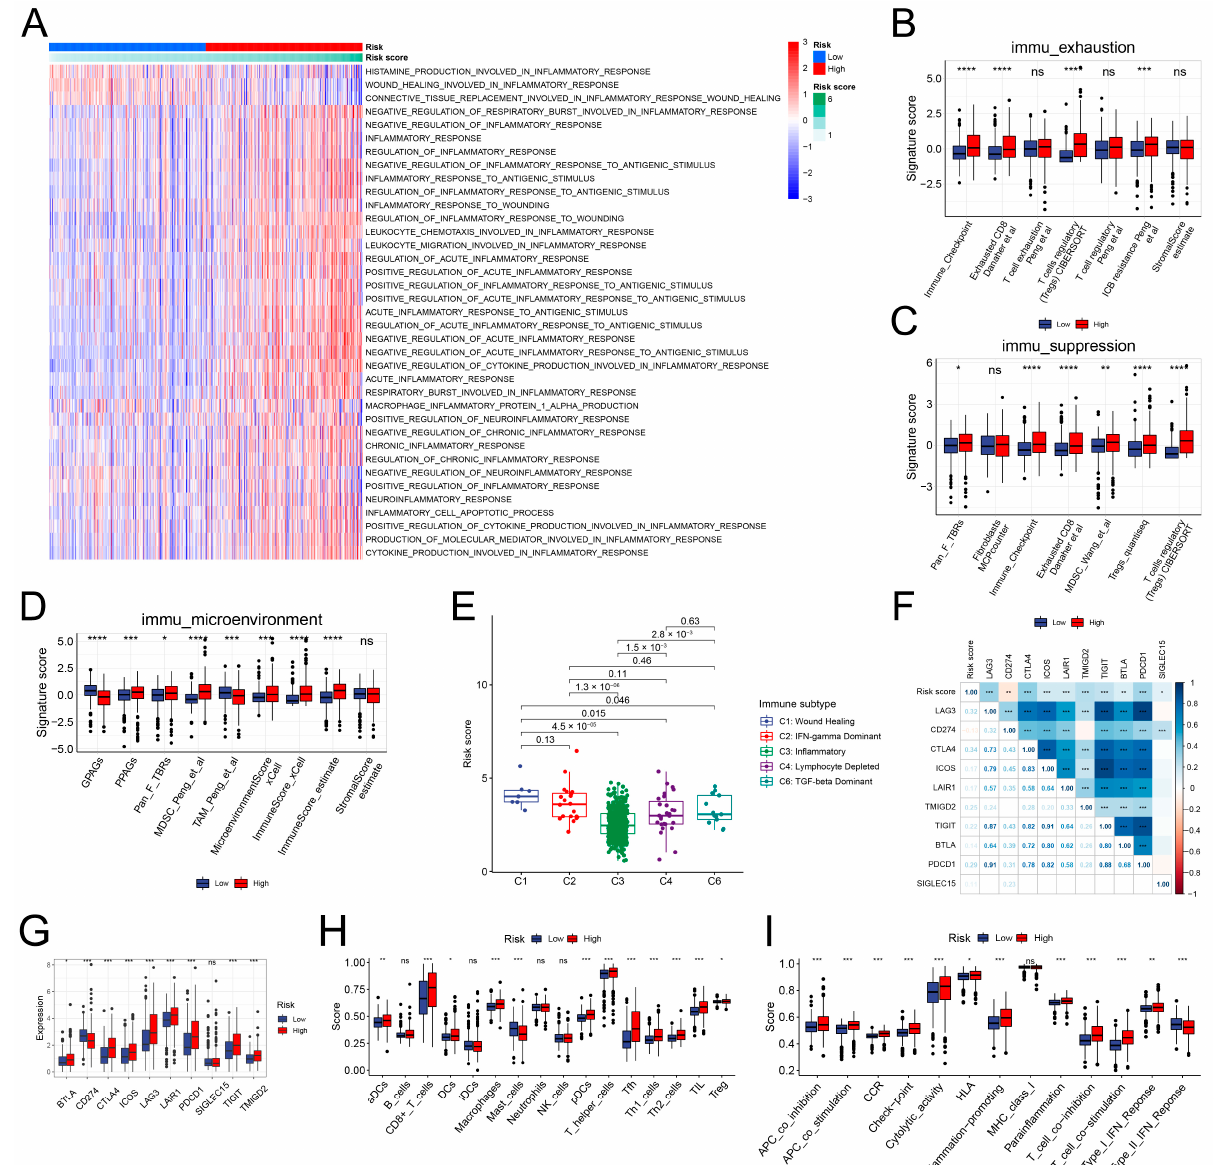
Figure 8. Immune characteristics between the two risk groups. ( A ) Functional enrichment of 37 inflammation-related BP terms from the different risk groups. ( B ) Immune exhaustion signature of both risk groups. ( C ) Immune suppression signature of both risk groups. ( D ) Immune microenvironment signature of both risk groups. ( E ) Risk score distribution in the different immune subtypes. ( F , G ) Correlation of the risk score with the inhibitory immune checkpoint genes. ( H ) Infiltration levels of the cells of the immune system in varying risk groups. ( I ) Correlation of the immune response processes with risk scores. * p < 0.05; ** p < 0.01; *** p < 0.001; and **** p < 0.0001.